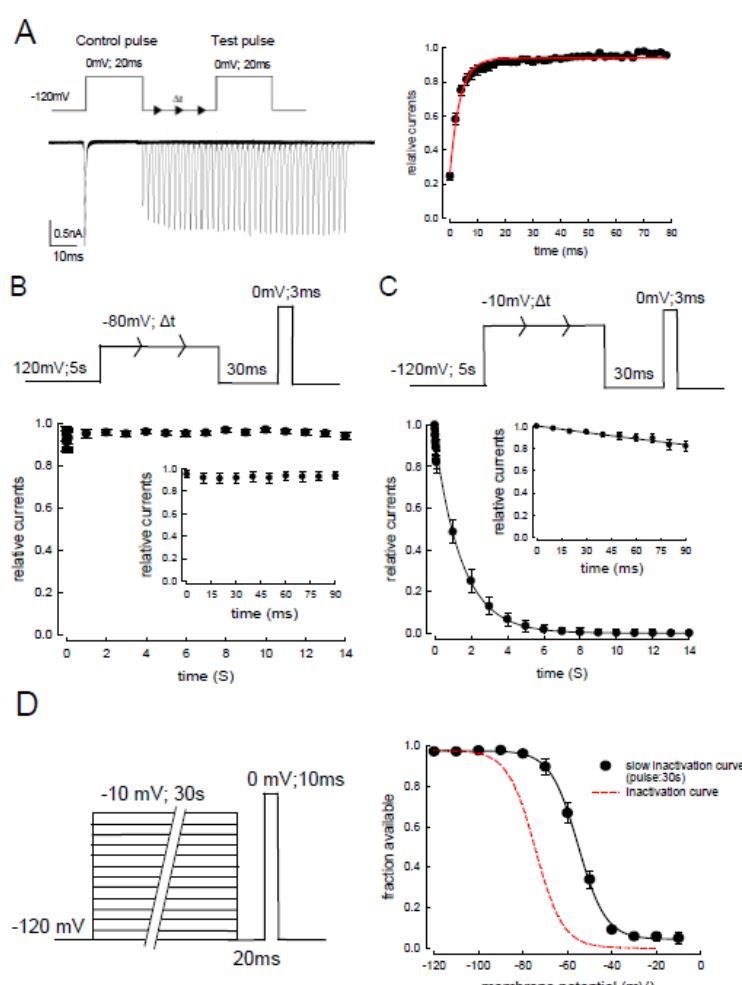
Figure 4. Recovery course from the fast and slow-inactivation curves in Na v 1.4 channels. ( A ) The cell was held at − 120 mV and pulsed twice to 0 mV (for 20 ms each) every 2 s, with a gradually lengthened gap between the two pulses at − 120 mV. Sweeps were arranged so that the currents in the second pulse gradually shifted rightward as the gap lengthened (by 1 ms each sweep, left panel). The relative current, defined as the normalized peak current in the second pulse to that in the first pulse, is plotted against the duration of the intervening gap (n = 5, right panel). The plot shows that most channels entering the fast inactivation recovered after approximately 20 ms at − 120 mV. ( B ) The electric protocol to evaluate the kinetics of slow-inactivation at − 80 mV. The patch CHO-K1 cell was held at − 120 mV for approximately 5 s, followed by a depolarized pulse − 80 mV for a certain time. Then, the current of − 120 mV for 30 ms was applied to the cell to allow full recovery from the fast inactivation. A test pulse at 0 mV for 3 ms was employed to evaluate the slow-inactivation. The elicited currents were normalized to the control current, relative currents, which was then plotted against the duration of the inactivating pulse at − 80 mV (time in seconds). The inset figure is a close-up view of the first 90 ms of data. Most (>90%) of the Na v 1.4 channels remained in the fast-inactivated state at − 80 mV. ( C ) The electric protocol to evaluate the kinetics of slow-inactivation at − 10 mV. The same protocols and analyses were employed as shown in Figure 4B, except that the inactivating pulse was set to − 10 mV (n = 5). In this case, most Na v 1.4 channels (>90%) entered the slow-inactivated state with a time constant of 1.43 s from the exponential fit to these points. ( D ) The patched cell was held at − 120 mV, and the pulse protocol was repeated every 30 s. Depolarizing prepulses of varying voltages from − 120 to − 10 mV (approximately 30 s) were applied to the cells, followed by a gap voltage at − 120 mV for 20 ms to allow recovery from fast inactivation. Subsequently, a test pulse at 0 mV for 10 ms was applied to evaluate the fraction of available channels. The curve was fitted using the Boltzmann function 1/1 + exp[(V − V h )/k], where the V h value was − 54.9 ± 0.7 mV and the k value was − 7.3 ± 0.5 (the black curve, right panel). The left of the inactivation curve from Figure 3B is replotted with a dashed line on the voltage